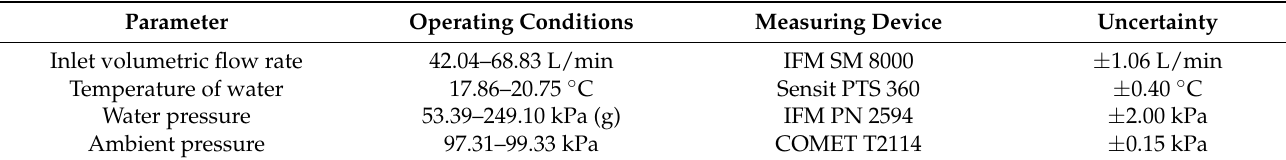
Figure 12. ( a ) Simplified piping and instrumentation diagram (P&ID) of the experimental setup with the n07 distributor; ( b ) photograph of the experiment using the n27 distributor. Table 4. Ranges of measured parameters and uncertainties of the measuring devices.